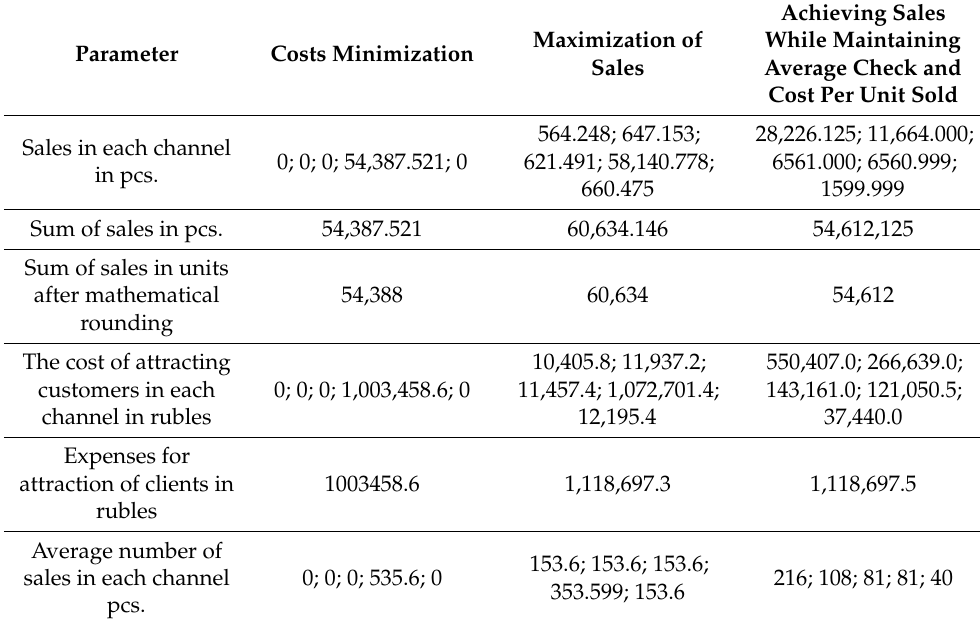
Table 14. The results of the optimization of the three proposed optimization